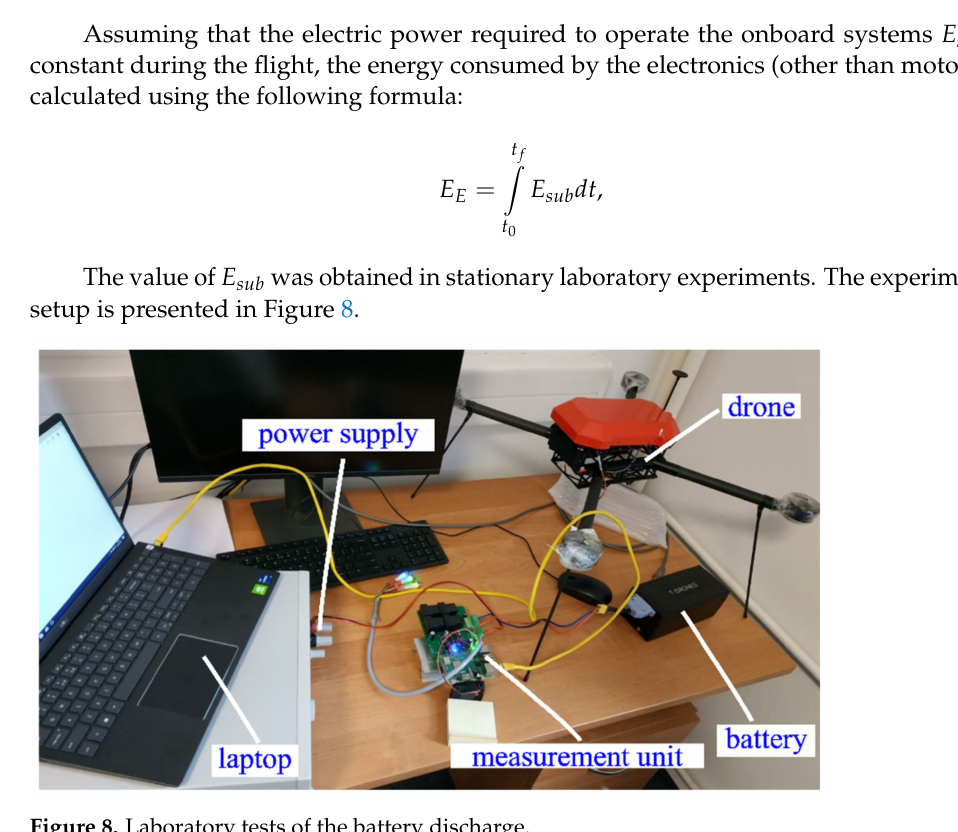
Figure 8. Laboratory tests of the battery discharge.